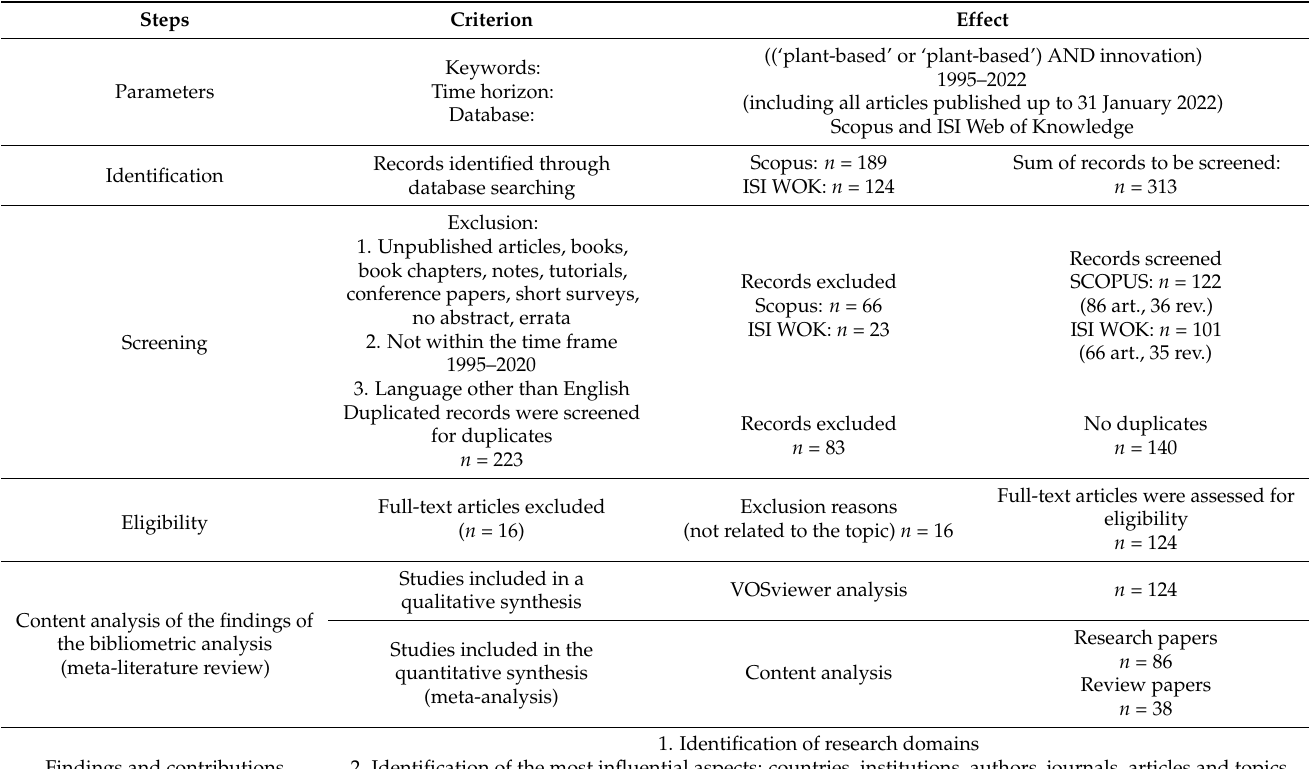
Table 1. The methodology of the literature